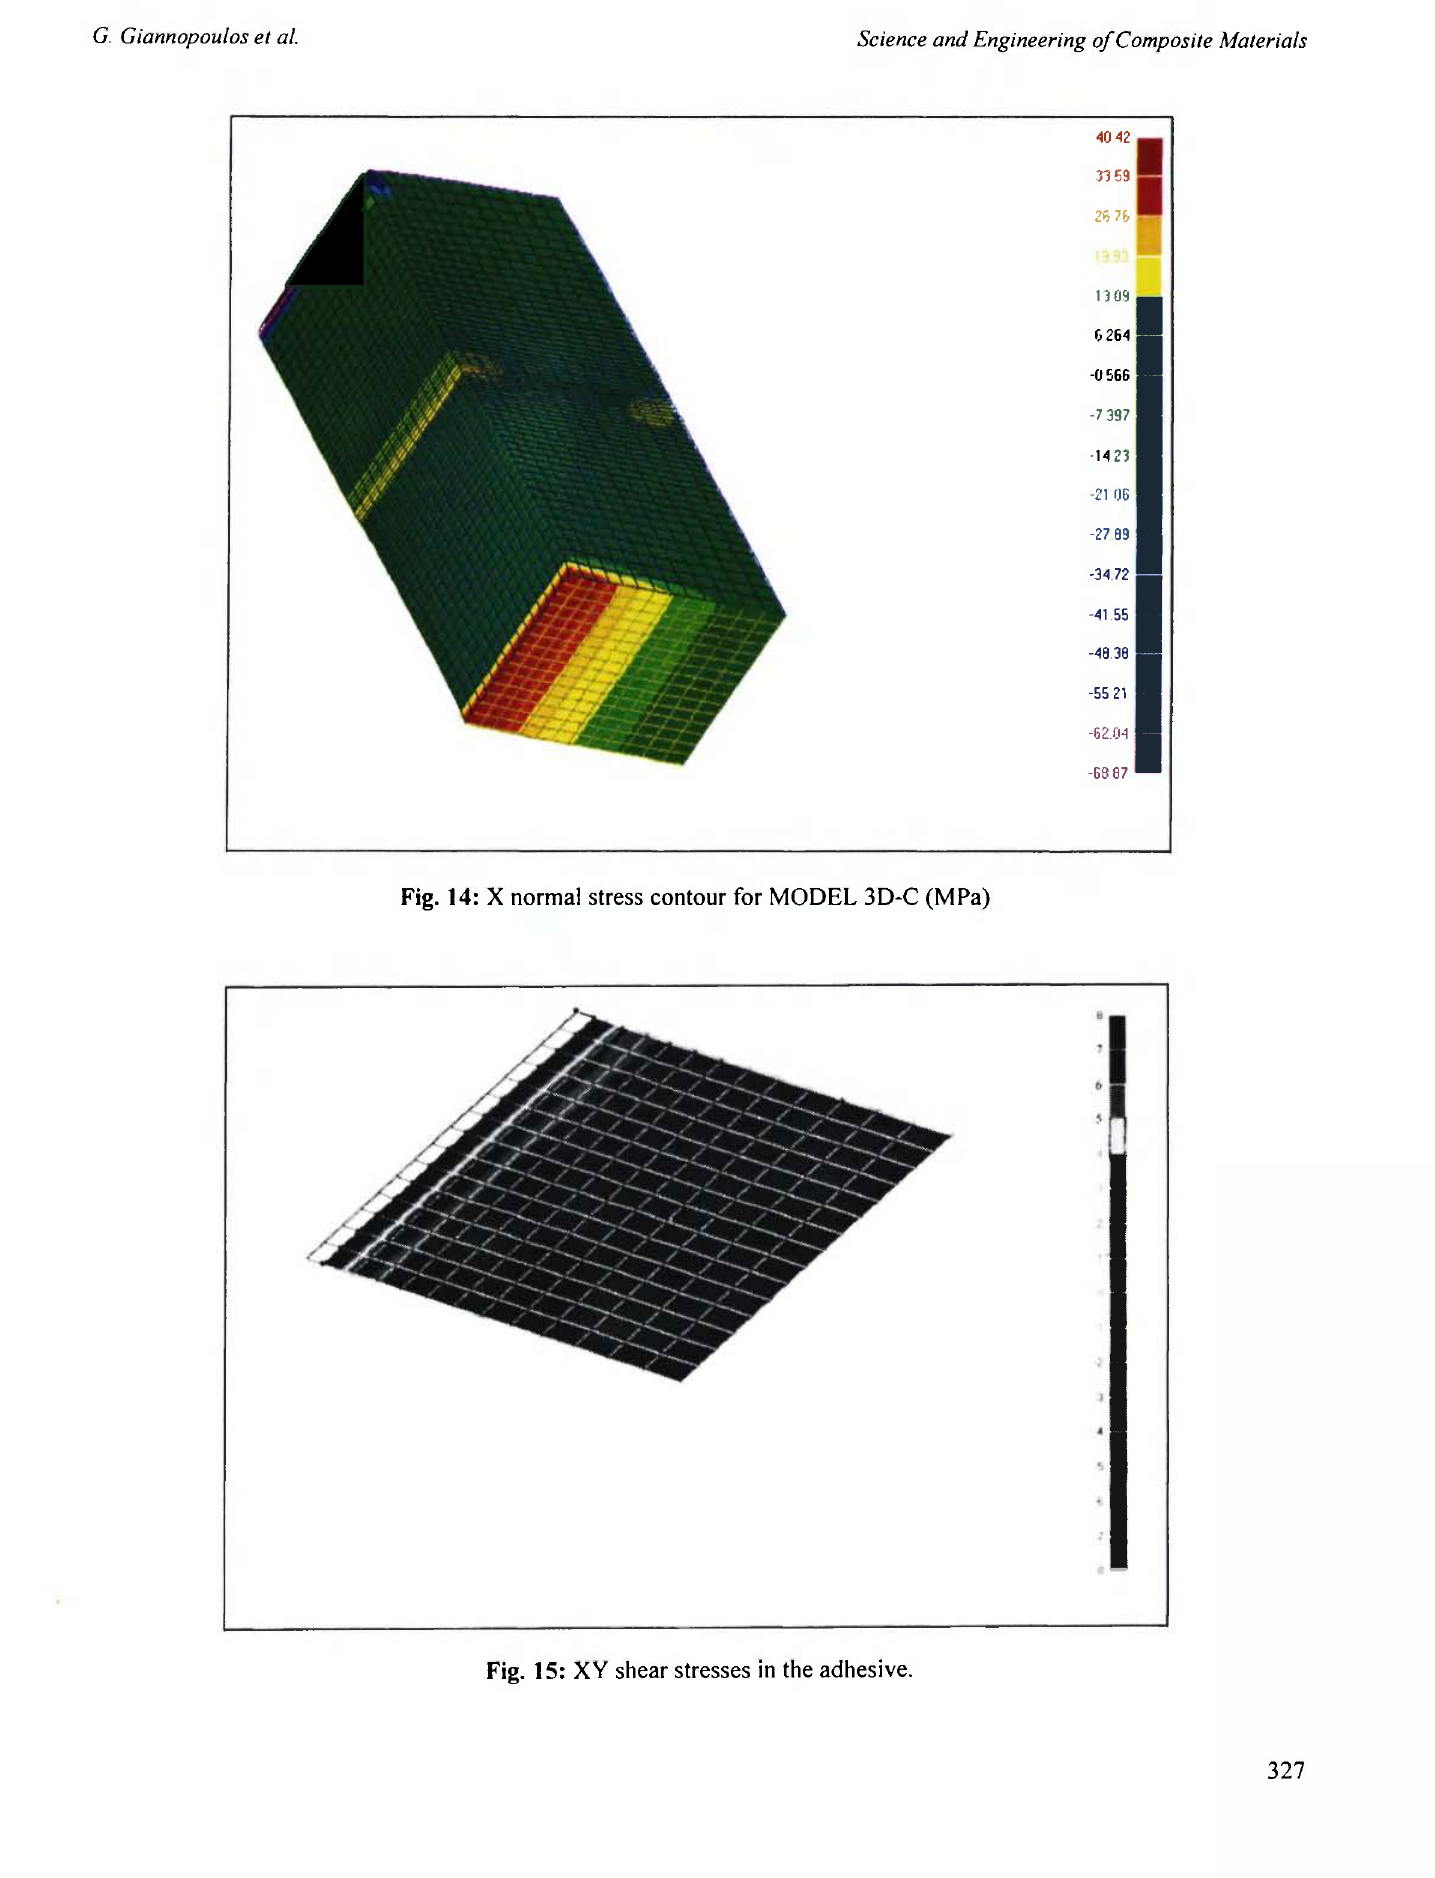
Fig. 15: XY shear stresses in the